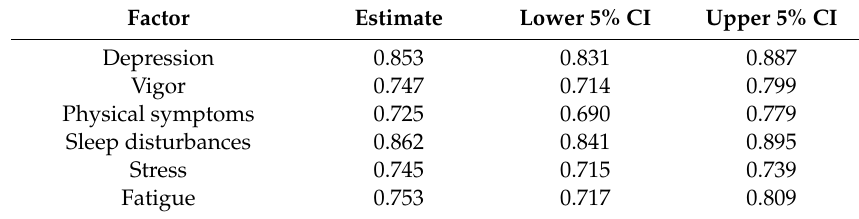
Table 8. Calculated McDonald’s ω along with confidence intervals (CIs) to estimate scale reliability. Factor